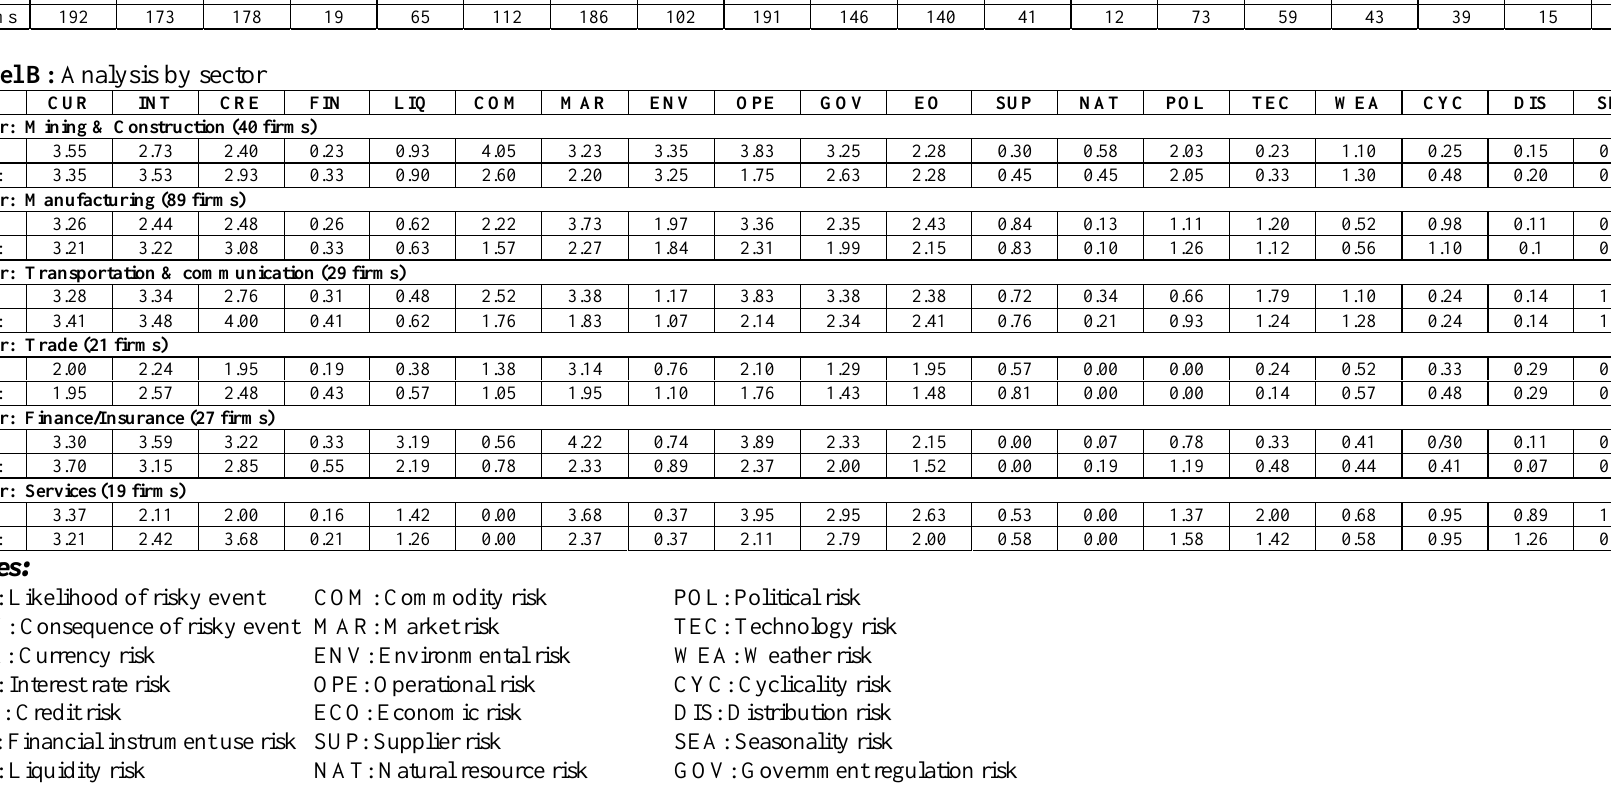
Panel B: Analysis by